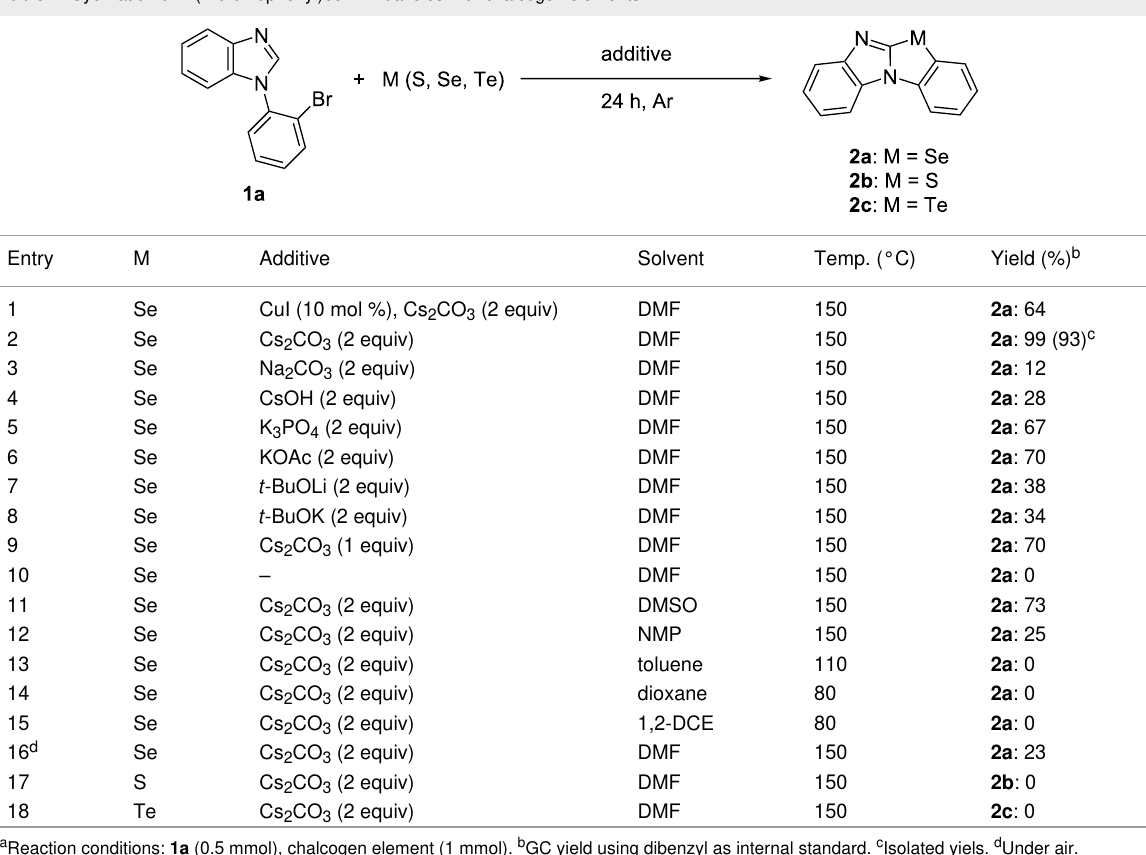
head-to-tail (antiparallel) stacking with π ··· π interactions, with distances between the nearest neighbor atoms on adjacent mole- cules being 3.333 (C8–C24) and 3.380 Å (C18–C13) (Figure 1b). Moreover, there were intermolecular interactions